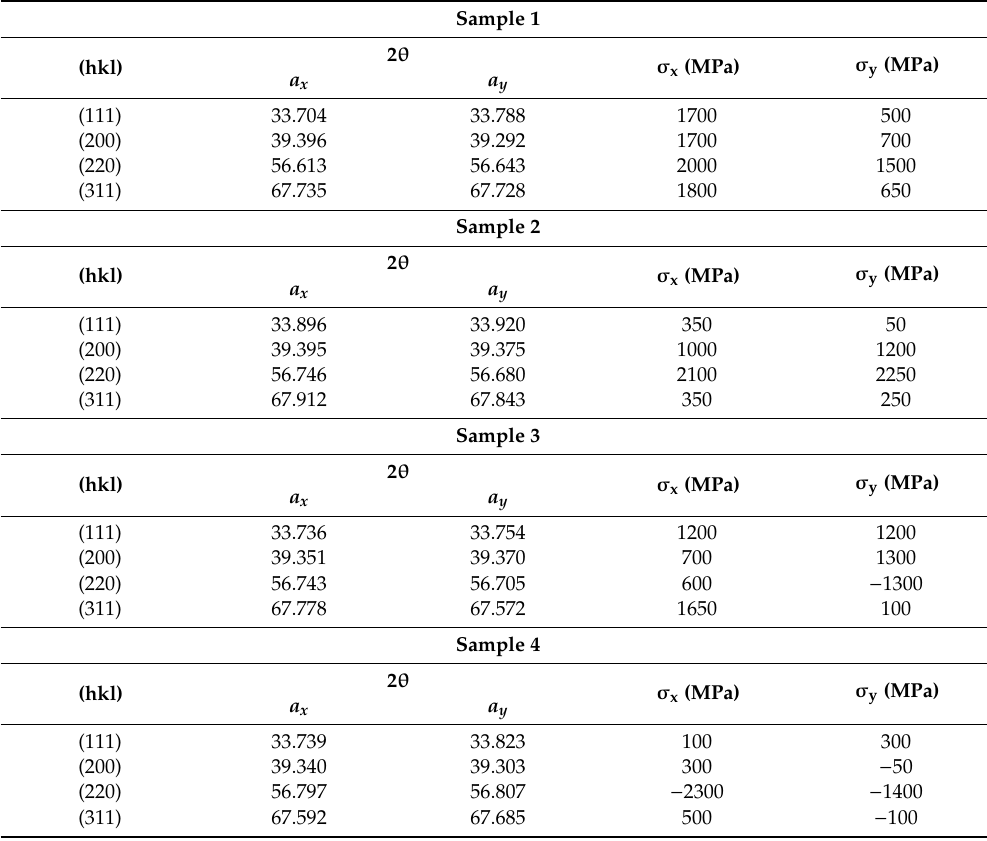
Table 3. Values of the lattice periods and stress calculated for the reflections characterized by elastic constants and, accordingly, different lattice deformation.